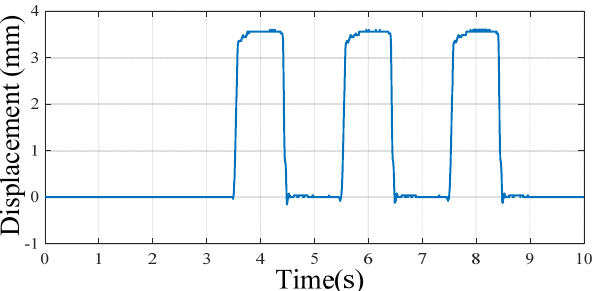
Figure 11. Displacement output of the stepping machine system with 3 continuous steps.